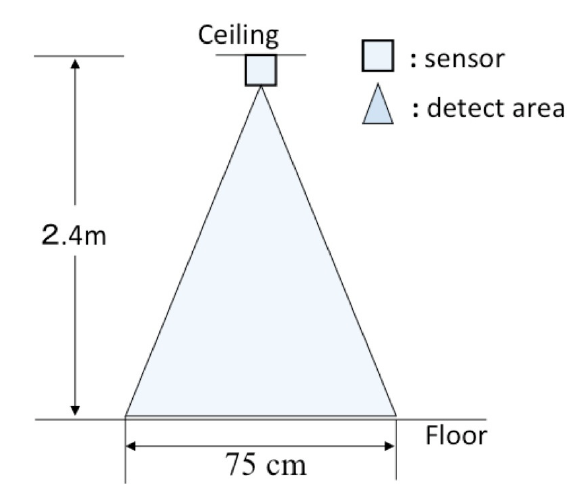
Figure 2. Side view of the detection area adjusted by a paper cylinder.